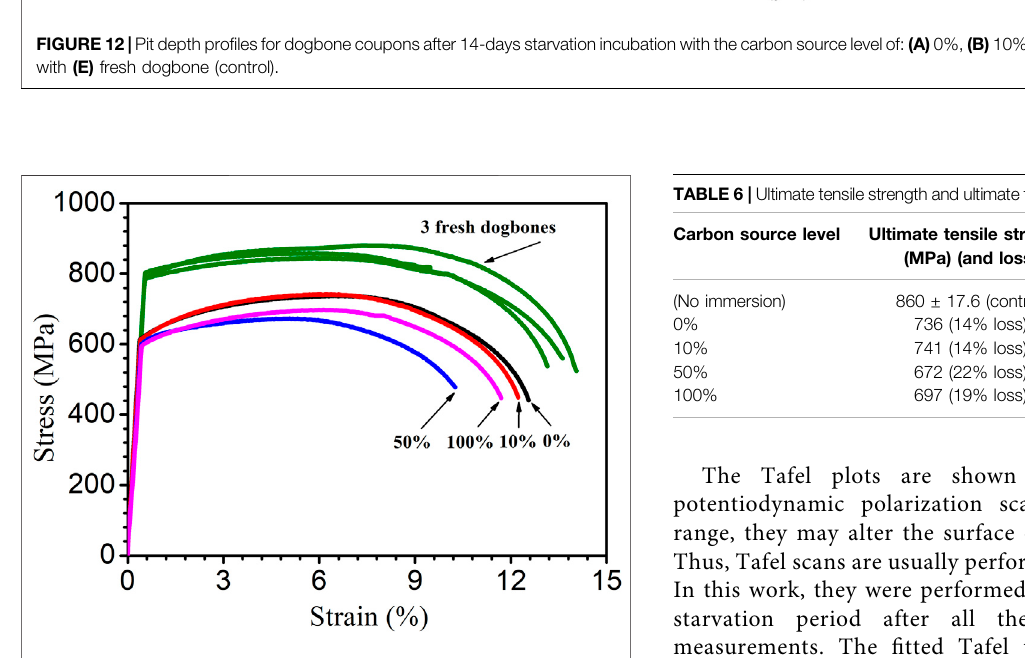
FIGURE13| Stress – strain curves forthreefreshX80dogbone coupons (three replicates) and dogbone coupons (with corrosion products removed) after 14-day starvation incubation in 450-ml anaerobic bottles with varied carbon source levels.